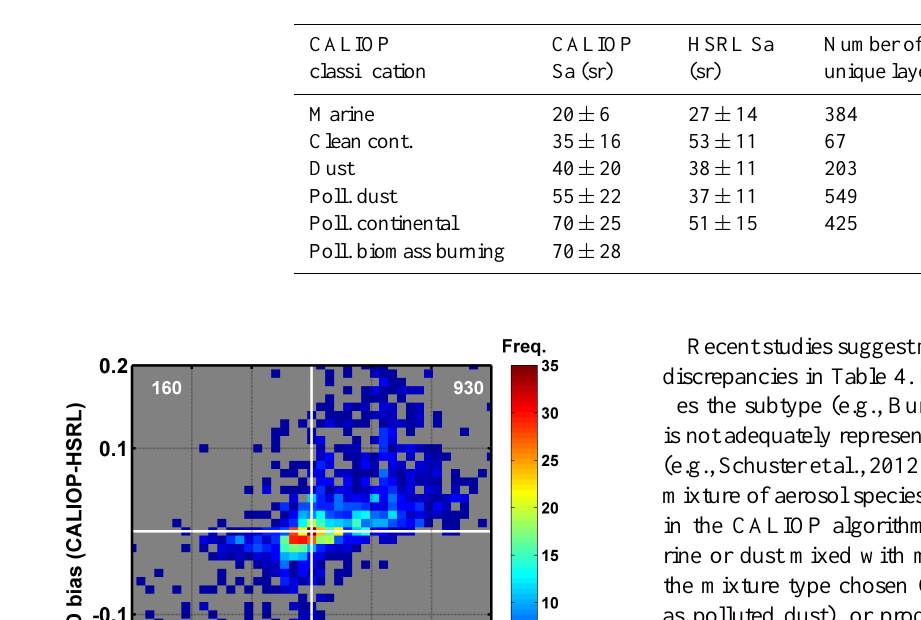
Table 4. CALIOP aerosol classification and corresponding combined (day + night) lidar ratios from both CALIOP and HSRL in the CALIOP classified layer. The first column lists the standard values (and uncertainties) used by CALIOP for the various aerosol classes, the following column lists the average values (and uncertainties) retrieved by the HSRL in the layers identified by CALIOP, and the last column shows how many unique layers were counted for each type.